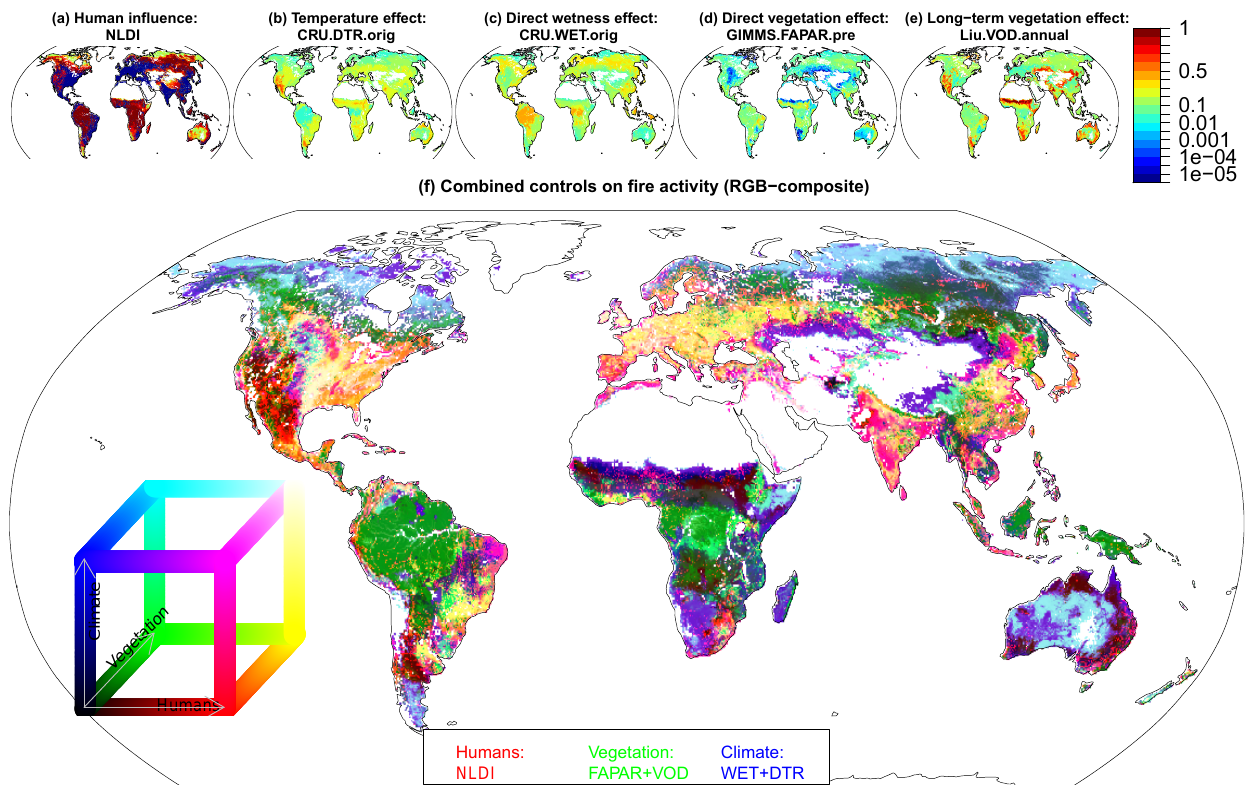
Figure 6. Example of combined climate, vegetation, and human controls on fire activity based on the SOFIA model SF.124421. The maps in (a–e) show the average response value for each functional relationship for the period 1997–2011. High values (1, red) indicate that this factor allows unlimited burning and low values (0, blue) indicate that this factor restricts burning. The map in (f) is a red-green-blue composite of the human influence (map in a , red channel), the combined direct and long-term vegetation effect (mean of d and e , green channel), and the climate effect (mean of b and c , blue channel). Bright and dark colours indicate a strong restriction and allowance of fire activity,